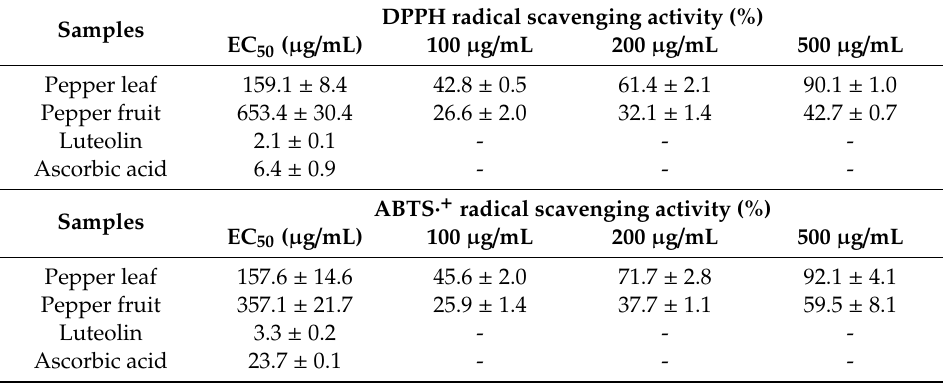
Table 1. DPPH and ABTS · + assays of radical scavenging activity of pepper leaves and pepper